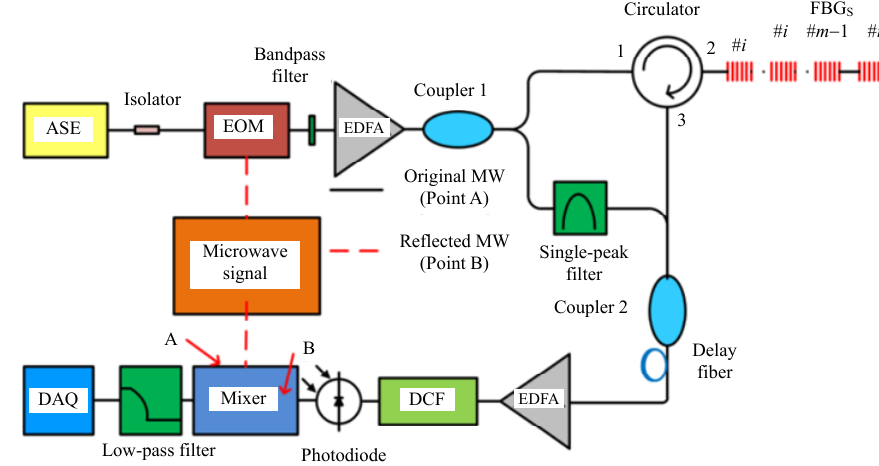
Fig. 5 Schematic of the system based on microwave photonics and chromatic dispersion